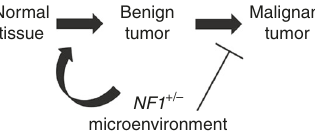
Fig. 7 NF1 heterozygosity fosters de novo tumorigenesis but impairs malignant transformation. Schematic summarizing the antagonistic role of NF1 + / − microenvironment on the sequential cancer progression from normal to benign to malignant